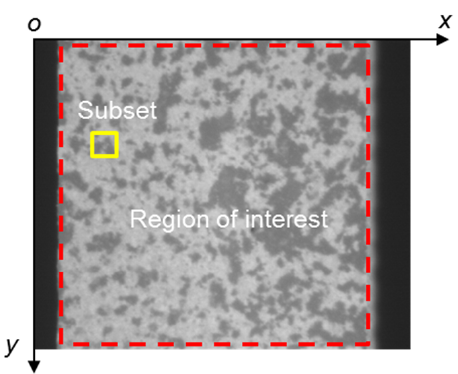
Figure 8. The speckle pattern image captured at 1073 K, the specified region of interest (ROI) and the imposed yellow square of subset used.